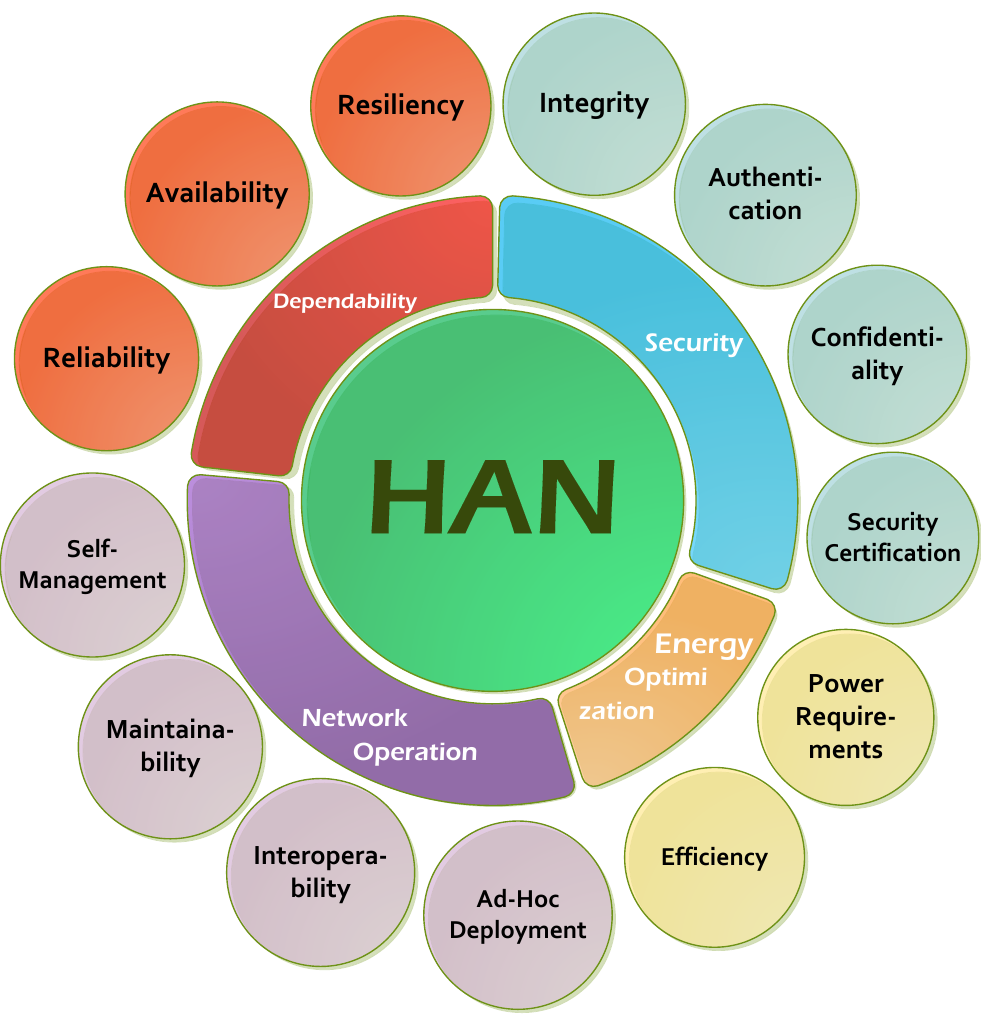
Figure 2. The classification of the main characteristics and requirements for